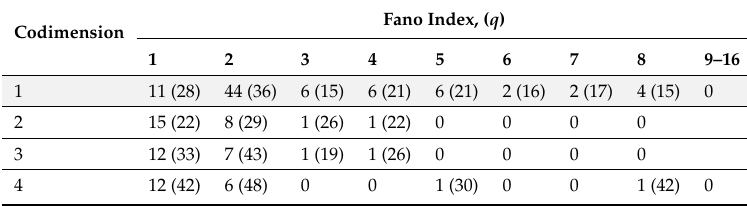
each codimension and exact search domain in each case. First column contains the codimension of each surface and the rest of the columns contain a pair of numbers. First number is the number of examples of given index and the second one gives the maximum value of q = W max − I for which the last candidate surface was found; the classification is complete until N = maximum ( 50,2 q ) . The entries with no second number means that no examples were found for q ≤